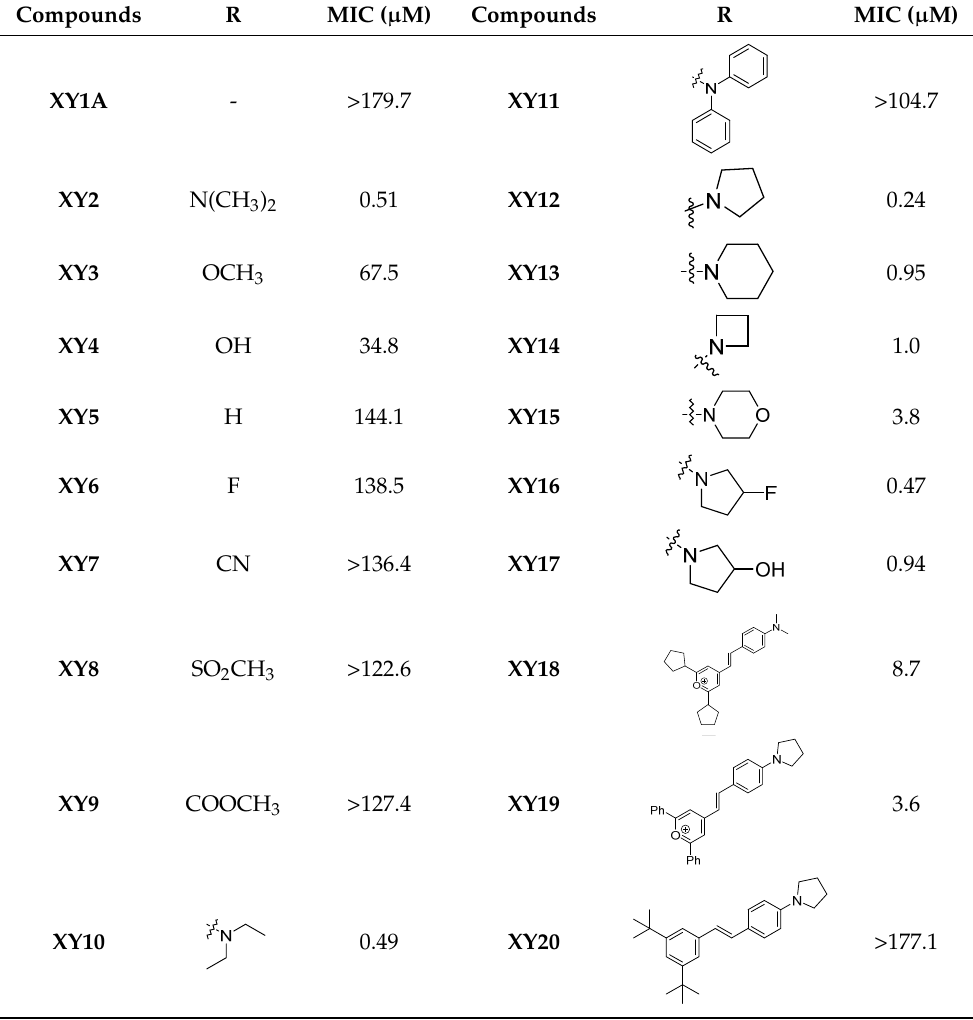
Table 1. In vitro antifungal activities of the target compounds against pathogenic C. albicans SC5314. Compounds